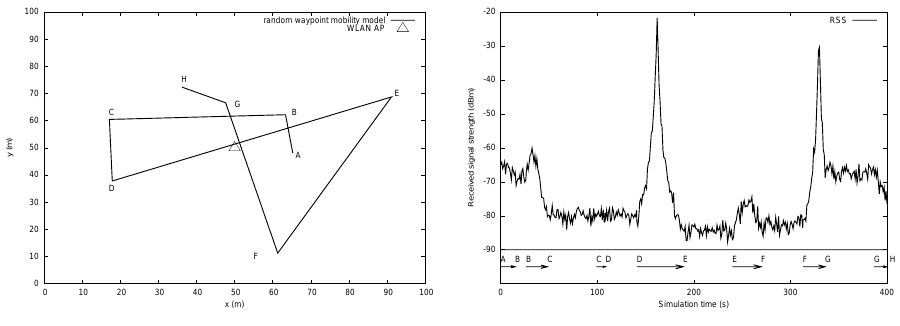
Figure 12. The feasibility analysis of MRSS in the WLAN